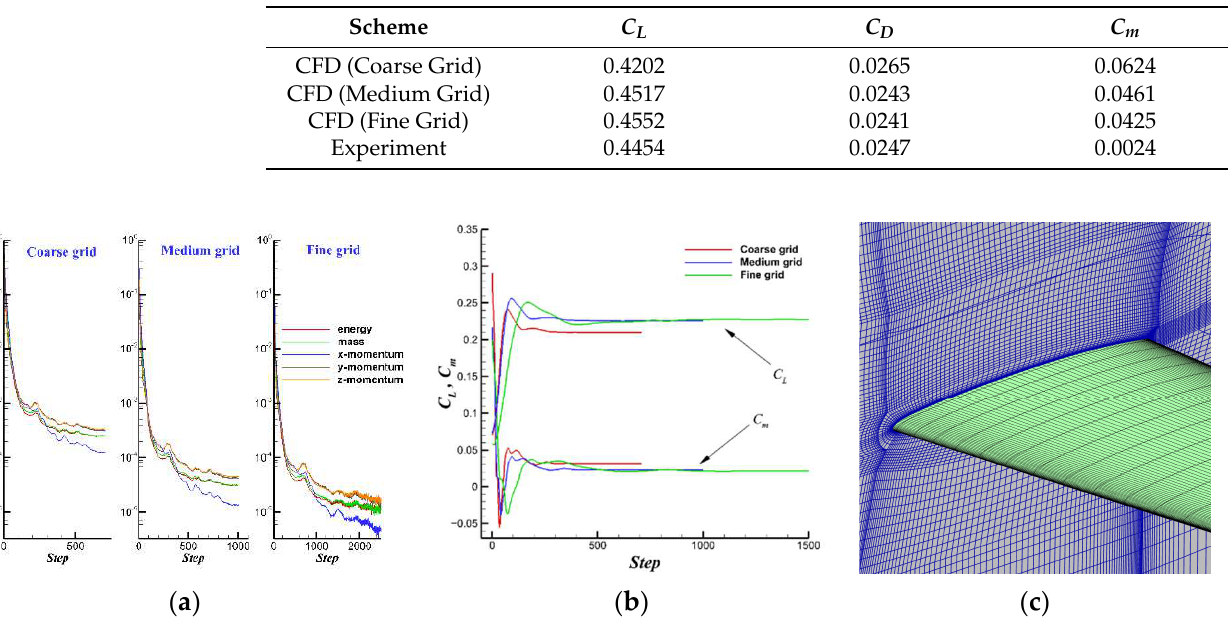
Figure 3. Convergence history of ( a ) residuals and ( b ) aerodynamic coefficients; ( c ) grid distribution of medium grid.